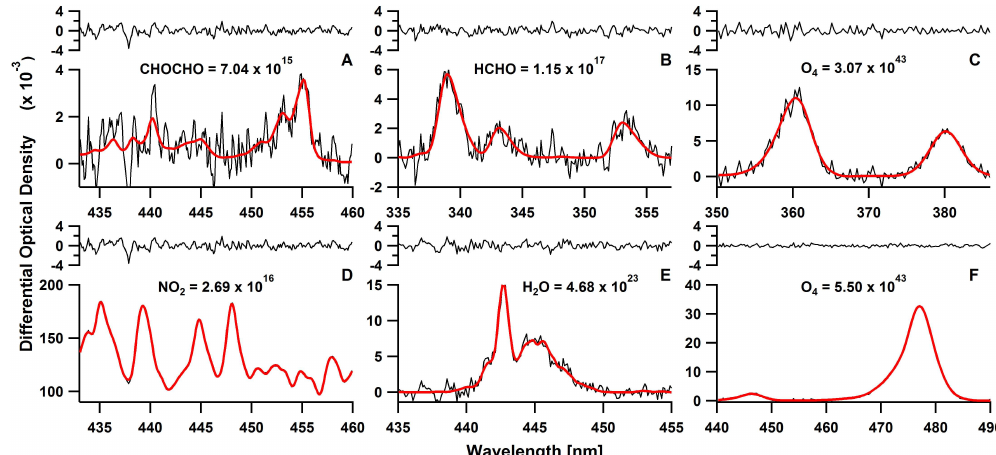
Fig. 4. Spectral proofs for the detection of (A) CHOCHO, (B) HCHO, (C) O 4 at 360nm, (D) NO 2 , (E) H 2 O and (F) O 4 at 477nm. CHOCHO and NO 2 fits are from 14 July 2010 at 22:08UTC (SZA: ∼ 42 ◦ ) at ∼ 150ma.g.l. HCHO and H 2 O fits are from 16 July 2010 at 20:19UTC (SZA: ∼ 24 ◦ ) at ∼ 600ma.g.l. O 4 fits are from the same flight at 20:11UTC (SZA: ∼ 23 ◦ ) at ∼ 3000ma.g.l. The black lines represent the measured spectra and red lines are fitted reference cross sections. Note that for NO 2 and O 4 at 477nm, the absorption is so strong that the black lines are not visible. All the fits are for 0 ◦ EA. The units for retrieved dSCDs for CHOCHO, HCHO, NO 2 and H 2 O are moleculescm − 2 and for O 4 are molecules 2 cm − 5 .